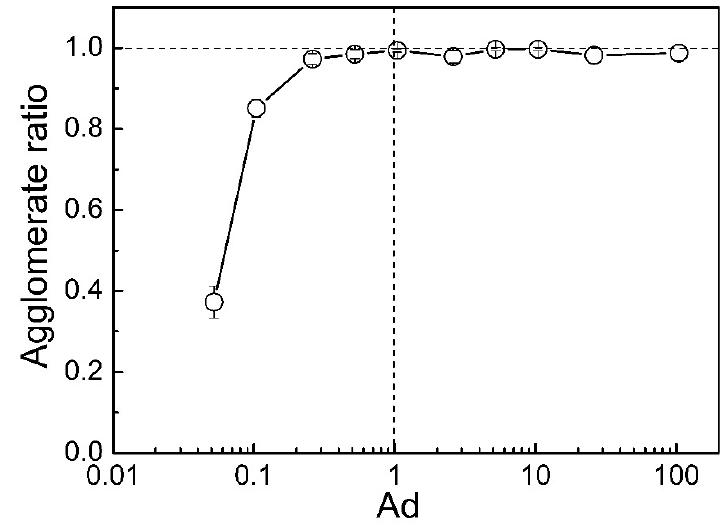
Figure 23. The agglomerate ratio as a function of the adhesion number. The vertical dashed line denotes the critical value of adhesion number in the present study. The data was originally reported in [38].